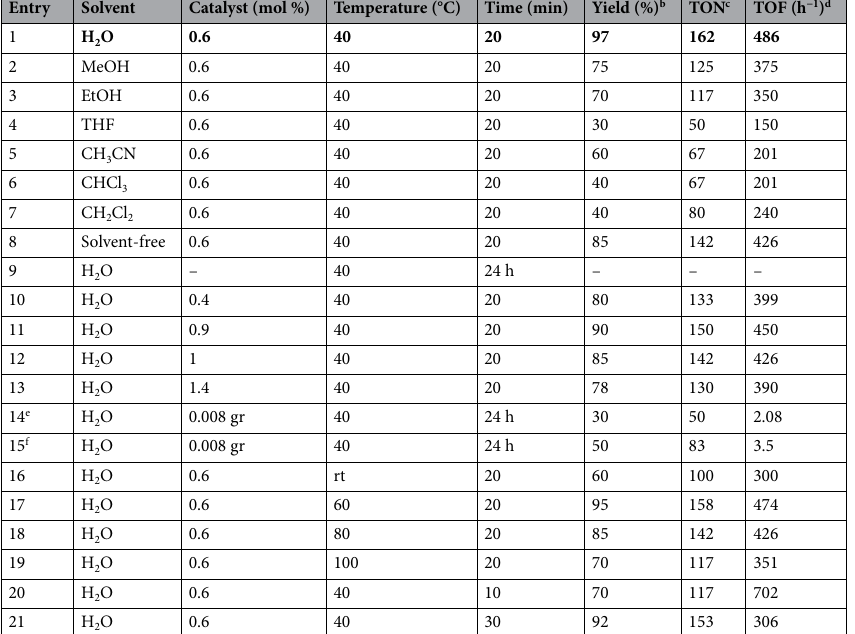
Table 1. Optimization of the reaction conditions for the synthesis of 1-aryl 1- H tetrazole derivatives. Significant values are in bold. a Aniline (1.0 mmol), Triethyl orthoformate (1.2 mmol), Sodium azide